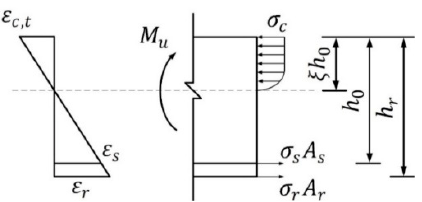
Figure 17. Simplified computation model for structural flexural capacity calculation.